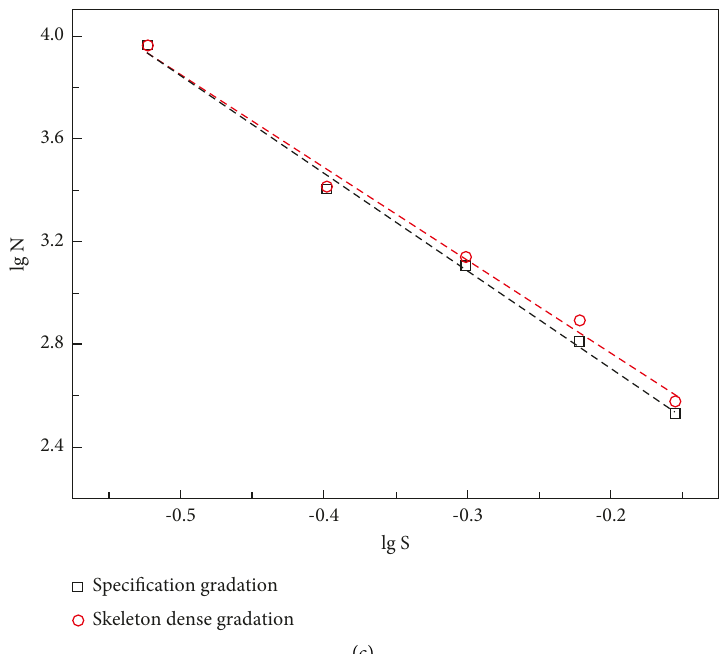
Figure 12: Fatigue curve of SMA-13 mixture with different gradations. (a) Marshall method. (b) SGC method. (c) VTM